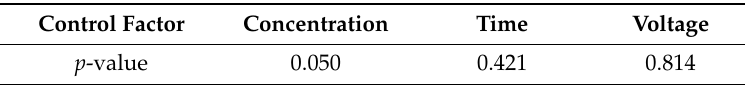
Table 8. MANOVA analysis effect of control factors on the deposition yield of zein/HA coatings made by EPD.